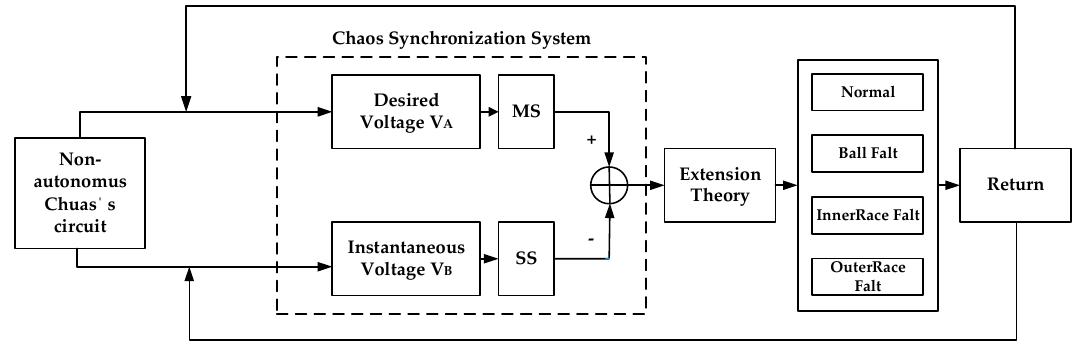
Figure 1. Ball bearing diagnosis system flow chart.